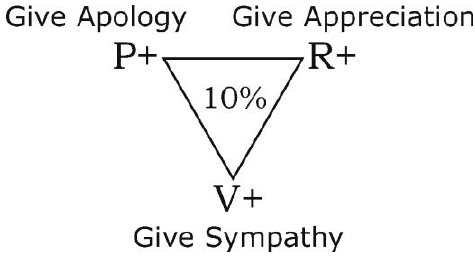
Figure 6: The Compassion Triangle 2.0